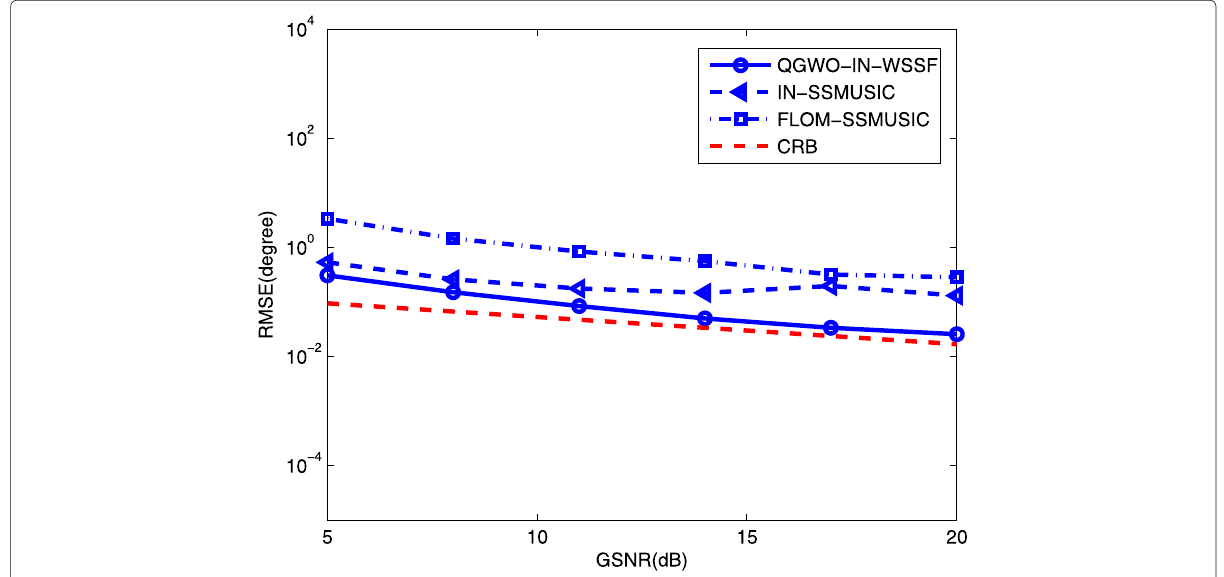
Fig. 10 RMSE curves and CRB versus GSNR for two coherent sources with α =